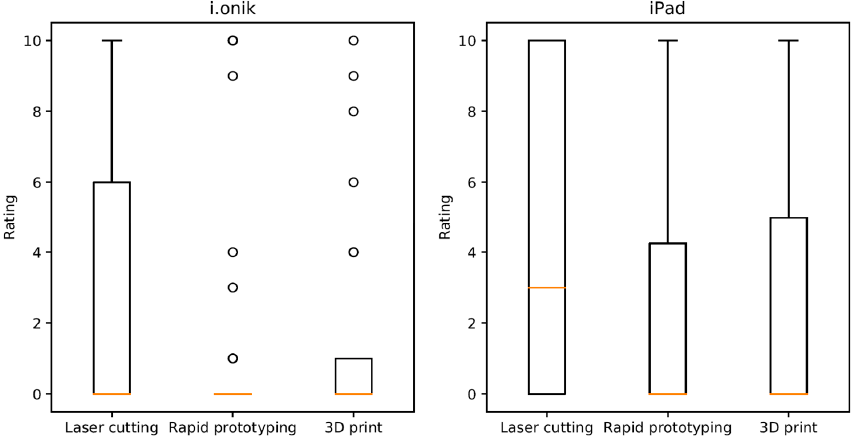
Figure 10. Differentiating the detection performance (“Rating”) regarding the fabrication techniques on each tablet.